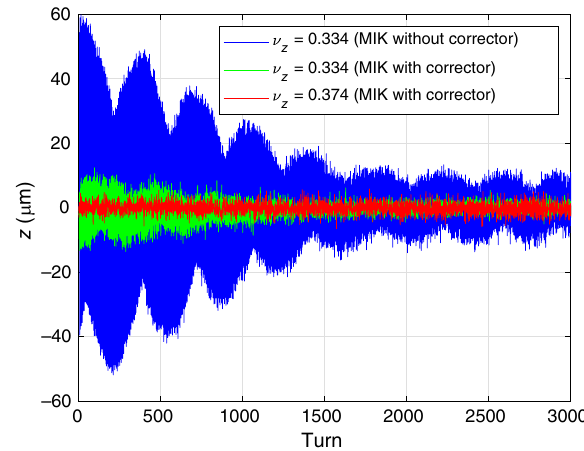
FIG. 13. Turn-by-turn variations of the vertical position of the stored beam. Measurements with β z ¼ 12 . 1 m. The MIK per- turbs the beam which exhibits large betatron oscillations without correction, for ν z ¼ 0 . 334 (blue). When the corrector is switched on, the amplitude of the betatron oscillations is divided by a factor of 6 (green). The correction is perfect for ν z ¼ 0 . 374